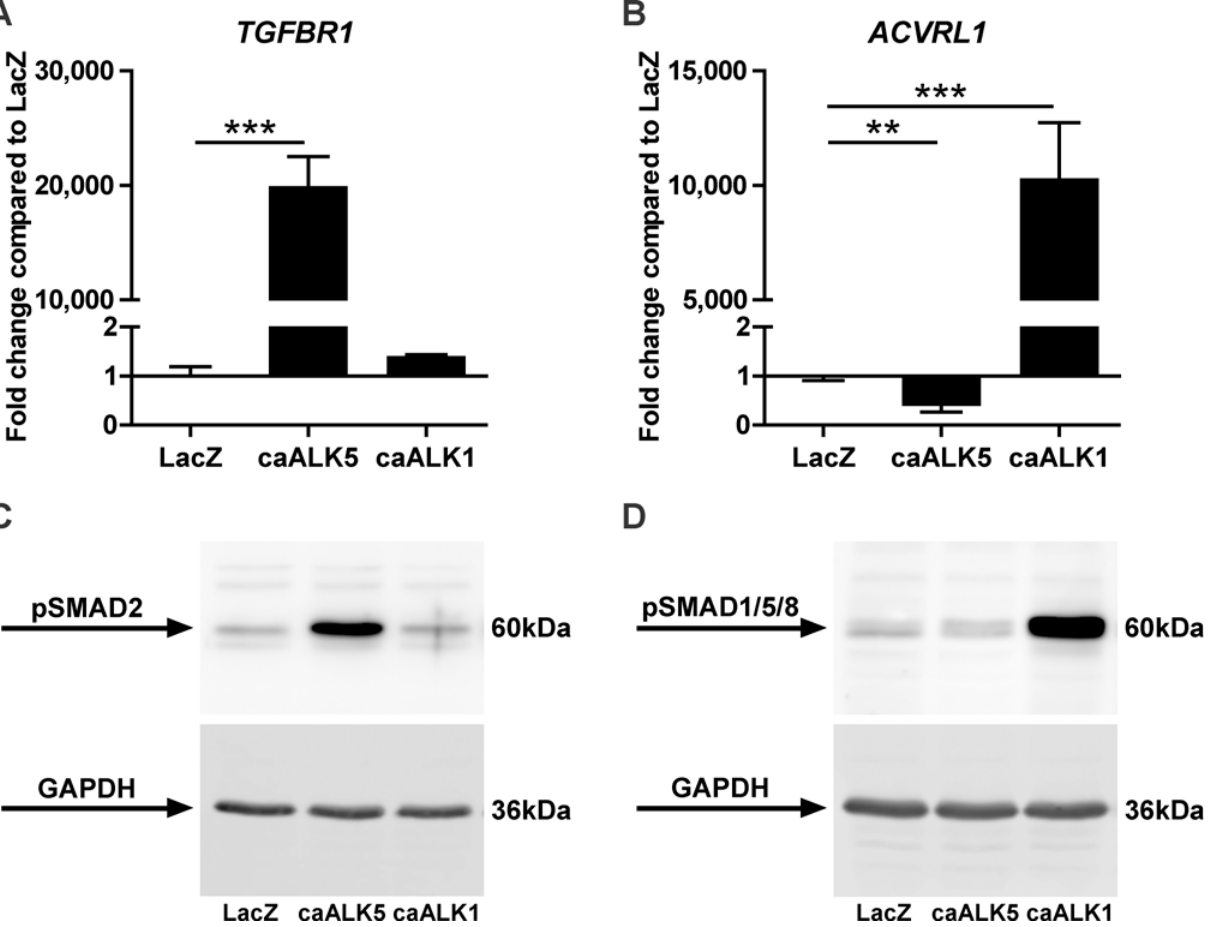
Fig 3. BMSCs overexpressing either constitutively active (ca) caALK5 or caALK1 express enhanced levels of phosphorylated SMAD2/3 and SMAD1/5/8 proteins, respectively. Human fetal BMSCs (donor F1) were transduced with adenoviral caALK5, caALK1 or LacZ as control and